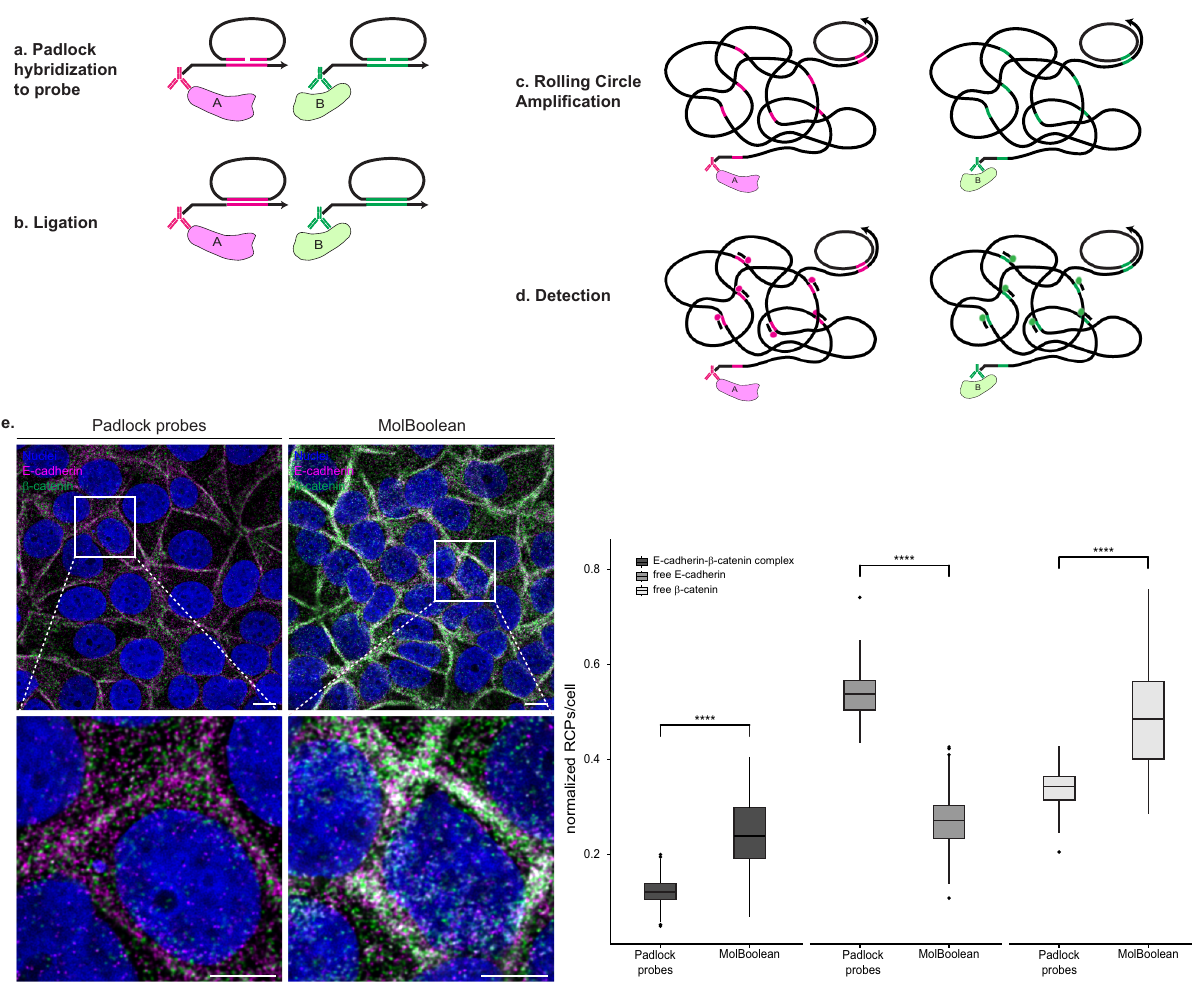
β -catenin respectively). E-cadherin is shown in magenta, β -catenin in green, E- cadherin- β -catenin complex (MolBoolean), or overlay (padlock probes) in white and nuclei in blue. White frames depict an area shown in enlarged view in the following panel. Scale bars=10 μ m. Quanti fi cation of protein complexes and free proteins shown as normalized number of RCPs per cell. n padlock =173, n MolBoolean =243 cells; data pooled from three independent experiments. Kruskal – Wallis and two-sided Dunn ’ s test with Bonferroni correction was used to analyze statistical variance. Box plots show median, Q1 to Q3 range, lower and upper whiskers at maximum 1.5 times the interquartile range. Outliers shown as solid circles. **** p <0.0001. Source data are provided as a Source Data fi